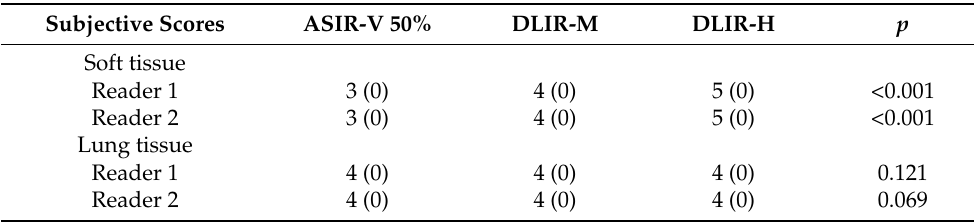
Figure 3. Lung tissue images of a 62-year-old female after chest LDCT. Three reconstruction methods were used: ASIR-V 50% ( a ), DLIR-M ( b ), and DLIR-H ( c ). The image signal did not significantly vary across different reconstructions (all p > 0.05). Image noise slightly varied across different reconstructions (all p < 0.05). However, both radiologists agreed that DLIR did not visualize the lung tissue more clearly. Table 5. Results of the subjective image